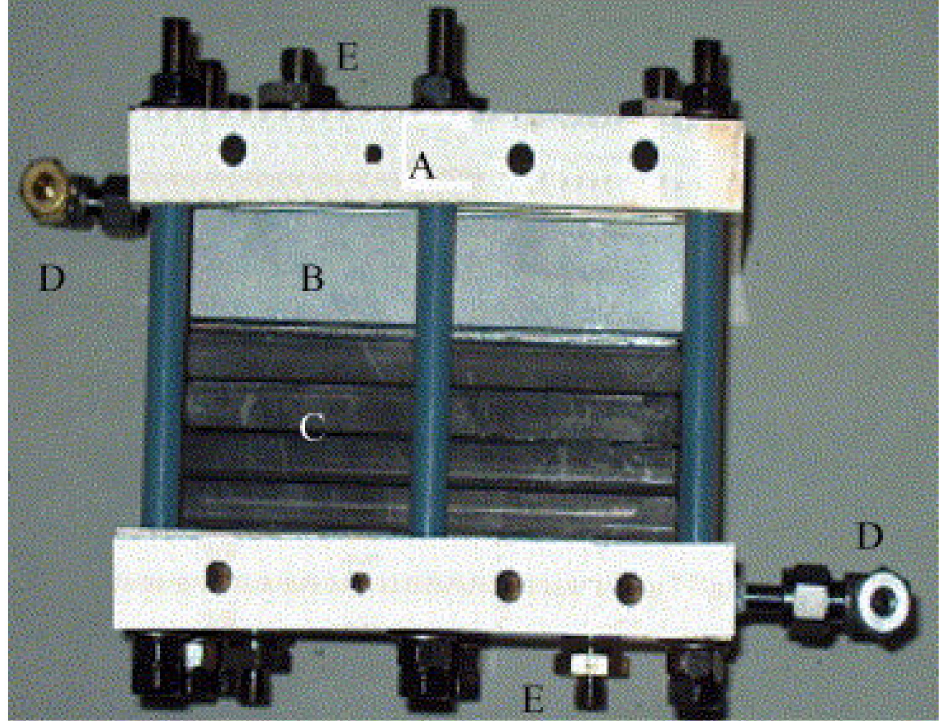
Figure 13. A two-cell stack with an integrated methanol reformer: ( A ) End plates with heating elements; ( B ) integrated methanol reformer; ( C ) PBI cells; ( D ) fuel inlet and outlet; ( E ) oxidant inlet and outlet. (Adapted from [49], copyright 2005,